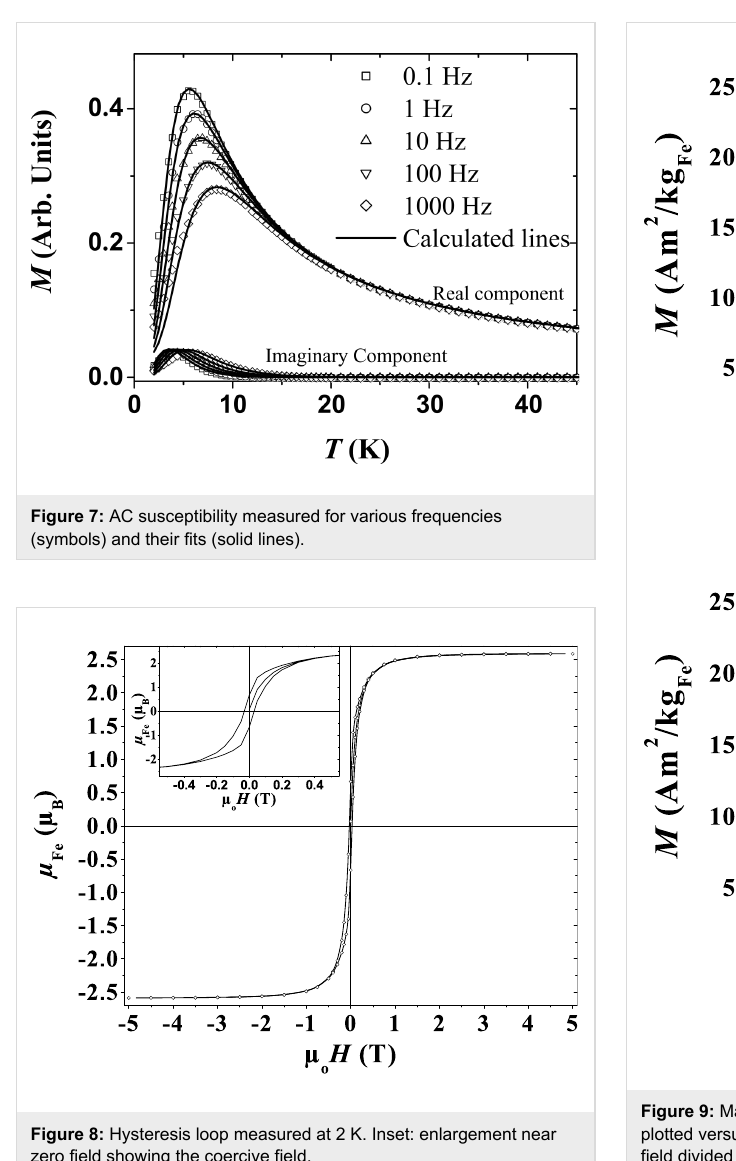
Figure 8: Hysteresis loop measured at 2 K. Inset: enlargement near zero field showing the coercive field.